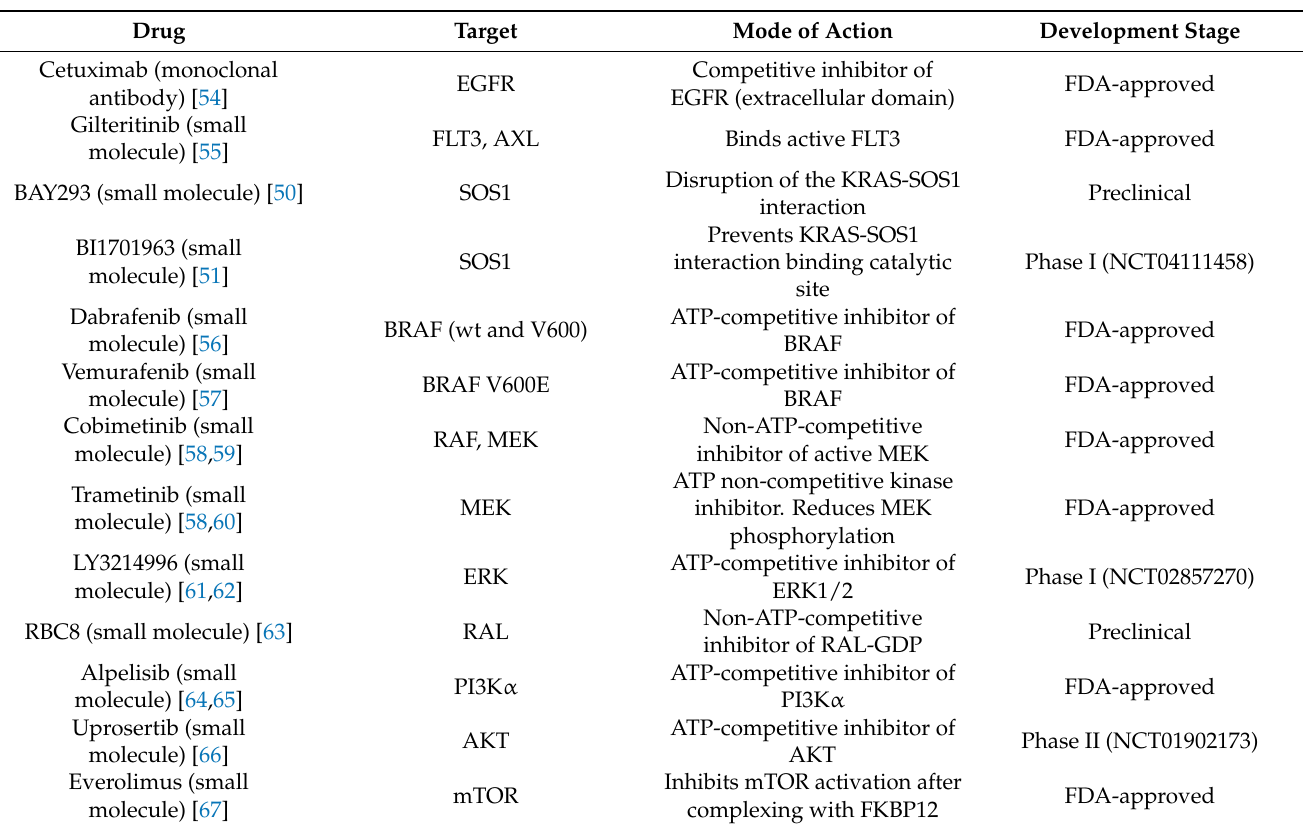
Table 1. Ras pathway targeting drugs at different stages of development. Adapted from Healy et al.